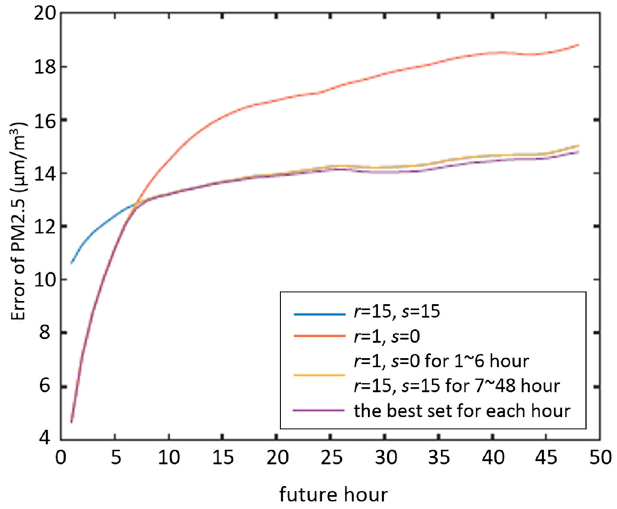
Figure 12. Comparison of the best r and s combinations.